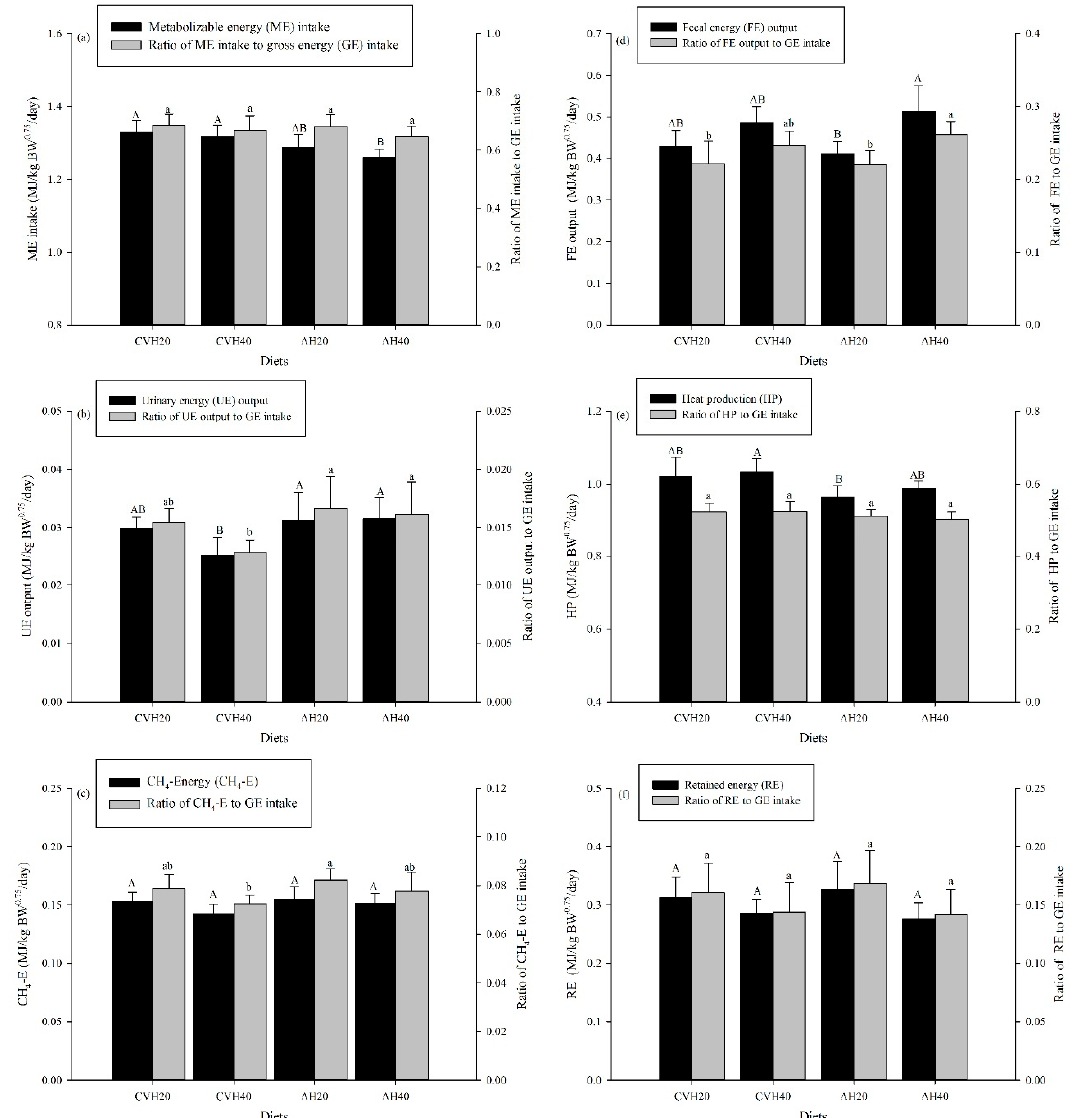
Figure 3. The energy balance and utilization efficiency of cattle among the four diet groups. Values are presented as the mean ± standard deviation (SD). Uppercase letters represent the differences among the four diet groups in energy balance, and lowercase letters represent the differences among the four diet groups in energy utilization. ( a–f ) represent ME intake, UE output, CH 4 -E, FE output, HP, and RE, respectively, as well as their proportion of GE intake. Table 4. A general linear model analysis of legume species (LS), legume proportion (LP) and their interaction effects on energy balance/nitrogen balance and energy/nitrogen utilization efficiency (n = 8).